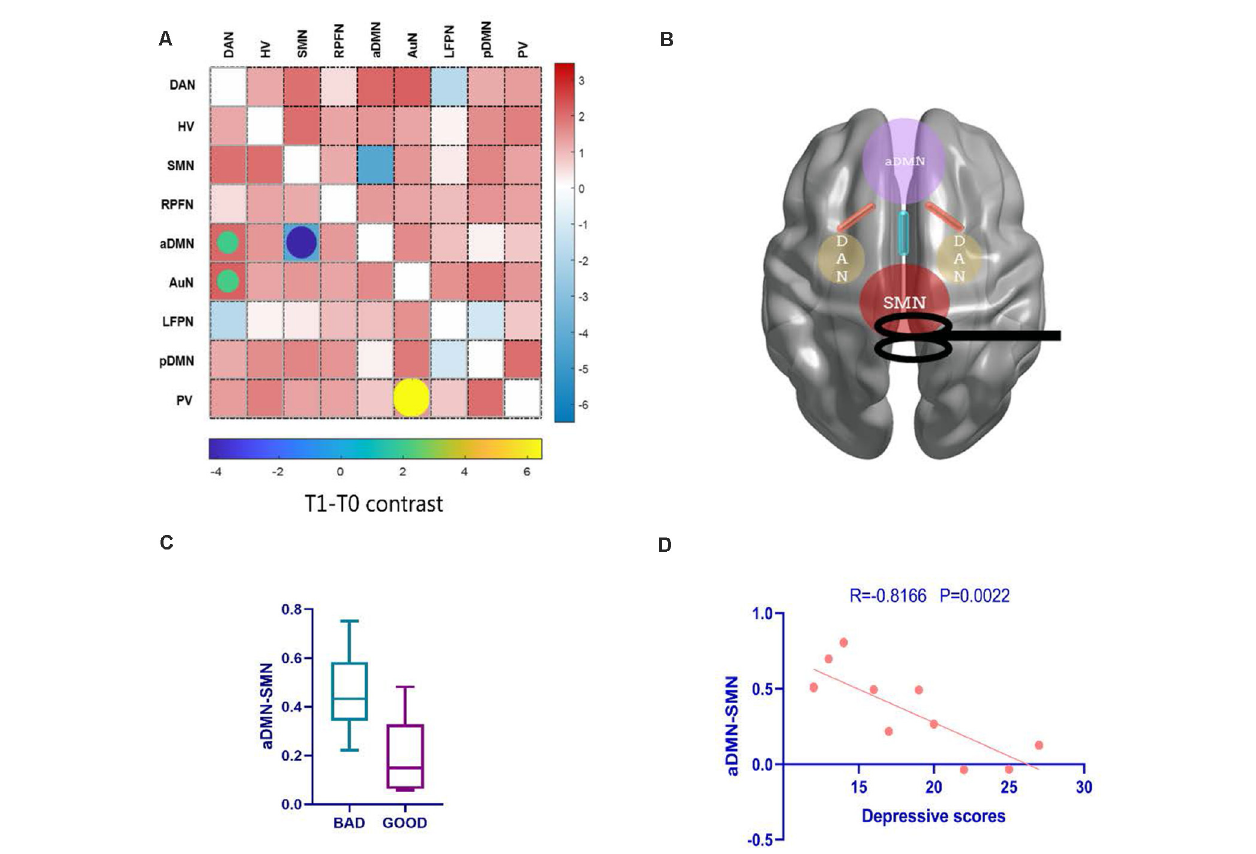
FIGURE 5 | The alteration of FNC and their clinical correlations after rTMS. (A) Posttreatment FNC in T1 shows a decreasing change in internetwork connectivity between the SMN and aDMN, while the DAN-aDMN, DAN-AuN, and PV-AuN pairs demonstrated hyperconnectivity after rTMS. (B) A conceptional graph of the important and temporary changes in T1. (C) Comparing bad and good response groups in T1, a two-sample t -test was used to test the significant difference in FNC z -value of aDMN-SMN ( p = 0.0115). (D) With the correlation analysis of the FNC in the aDMN-SMN and depressive scores, the results showed a more than moderate correlation (Pearson’s correlation r = − 0.67, p = 0.0022). AuN, auditory